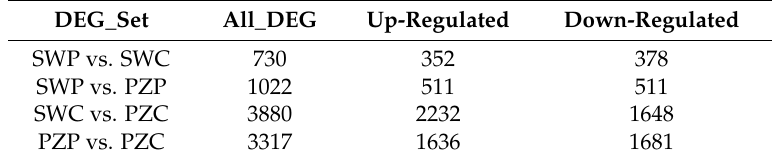
Table 2. The number of differentially expressed genes between different